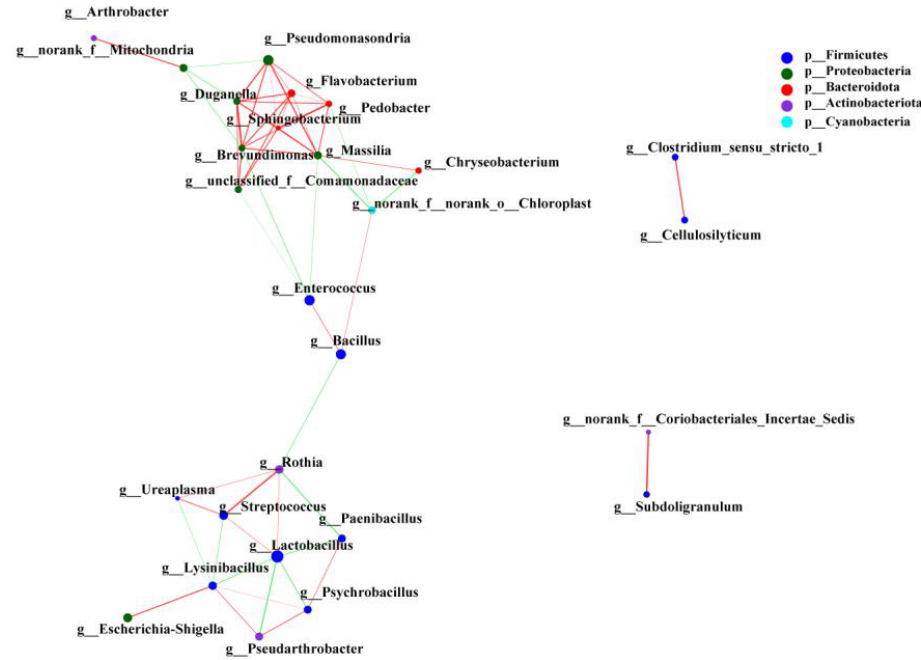
Figure 5. Single factor correlation network analysis of intestinal microbiota of SL Anser fabalis . The Spearman correlation coefficient was calculated between the total abundance of CL A. fabalis intestinal microbiota species in the top 30 genera. As shown in Figure 6, the positive correlation between Firmicutes and Actinomycetes is the main network relationship in the intestinal microbiota of CL A. fabalis , and there is also a low correlation with Firmicutes .